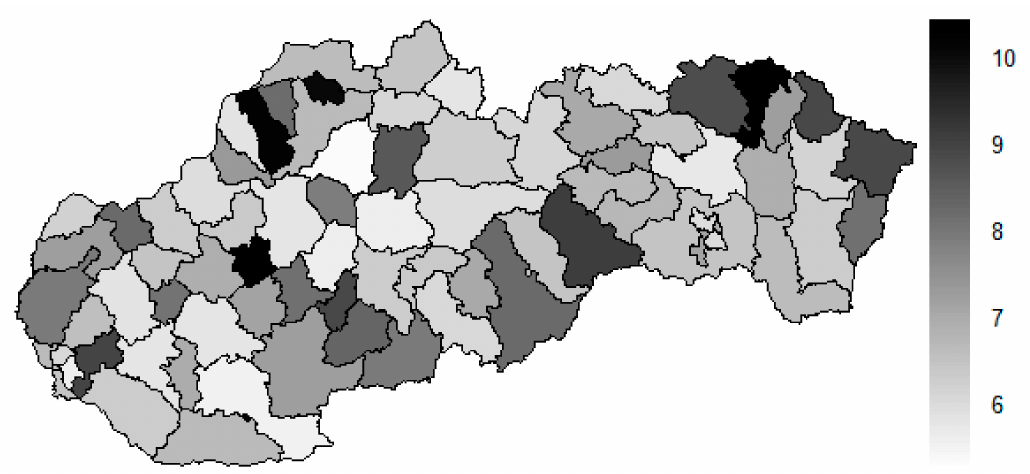
Figure 29. Preventable mortality similarity map of the districts for the male sex in the year 2015. Source: own elaboration by the authors.